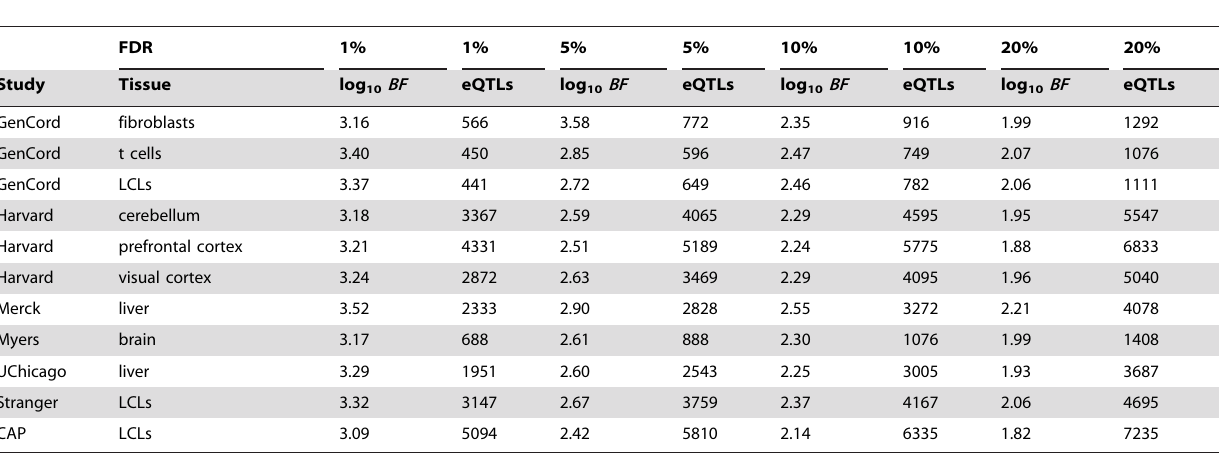
Figure 1. Uniform analysis of multi-cell type eQTL data sets. Studies are labeled by their acronym from Table 1. (A) Plot of log 10 FDR (y-axis) as a function of log 10 BF (x-axis), for each study as a separate line of a diferent color, as indicated in panels B, D, and E. Dashed line represents FDR ƒ 5% . (B) Plot of log 10 eQTL counts as function of log 10 BF , for all studies. (C) eQTL count (x-axis) by tier, for tiers 1–4 (light blue, dark blue, light green, and dark green, respectively), with separate bars for each study (y-axis). (D) Fraction of genes with a significant eQTL SNP (y-axis; thresholded at FDR ƒ 5% ), as function of sample size (x-axis). Each study is plotted in a distinct color, as indicated with labels. Studies with replicate expression measurements are depicted as triangles, studies without as circles. (E) Fraction of genes with a significant eQTL that have more than one independently associated SNP (y-axis; thresholded at FDR ƒ 5% ), as a function of sample size (x-axis). Each study is plotted in a distinct color. Studies with replicate expression measurements are depicted as triangles, studies without as circles. (F) Histogram of eQTL counts by tier (y-axis; colors as in panel C), summed across studies, as a function of their distance to the gene transcription start and end sites (x-axis; gene split into 10 bins). P (grey) line depicts the counts of first tier eQTL SNPs from a permutation, to illustrate the background distribution of tested SNPs. doi:10.1371/journal.pgen.1003649.g001 BF cutoff values for 1%, 5%, 10%, and 20% Table 2. Study-specific cis-eQTLs and log 10